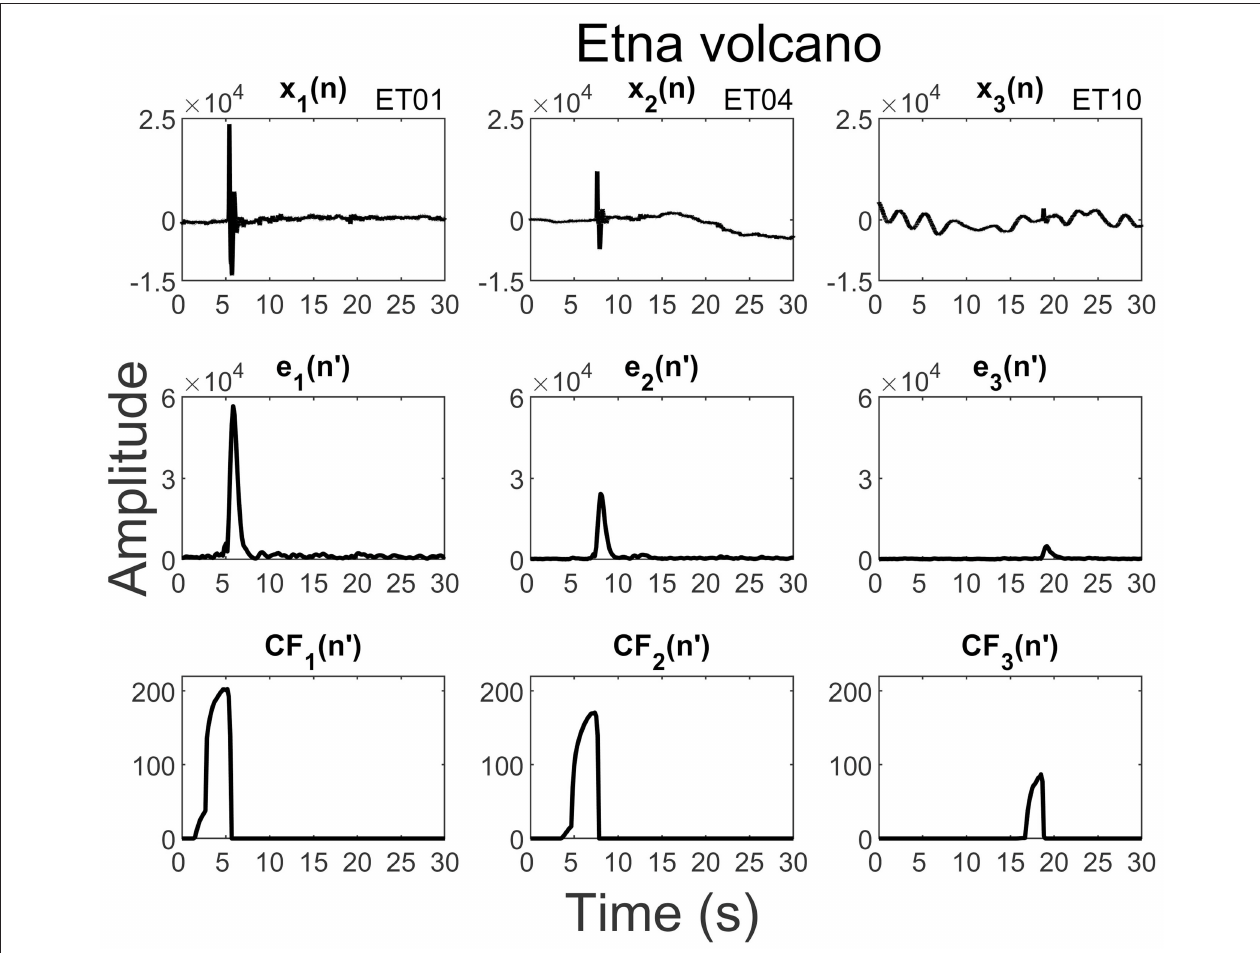
FIGURE 3 | Application example on a multi-station configuration at Etna volcano in three different stations ( ET 01, ET 04, and ET 10 located at 1.0, 1.3, and 6 km from the vent, respectively; Diaz-Moreno et al., 2019). Even if attenuated, the detector can recognize explosions at distant stations. When deployed on a single station, CF 3 could be considered as a false positive. However, when complemented with other CFs and propagation models, the number of false positives could be further